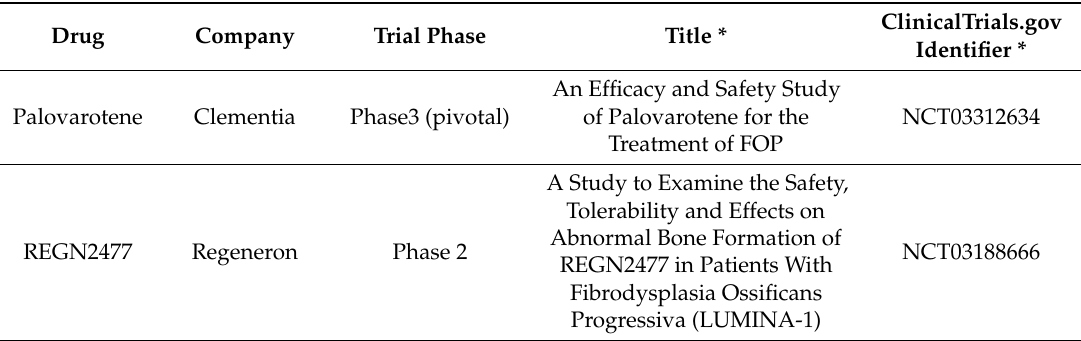
Table 2. Approved clinical trials for investigational drugs to treat